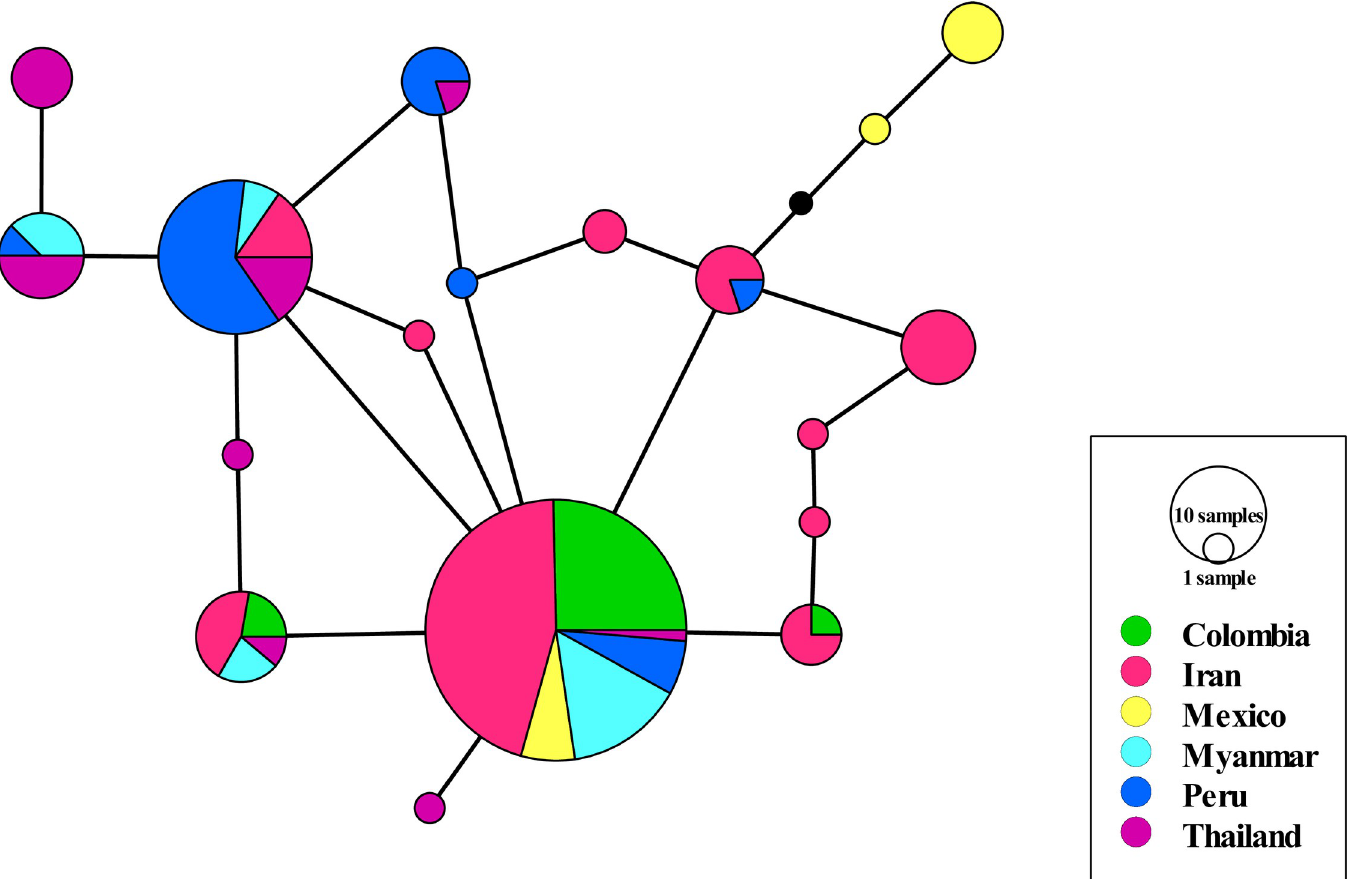
Fig 3. A haplotype network using pvrbp2b DNA sequences of global P . vivax isolates from Iran and other malaria endemic areas (n = 155). The median-joining method was used to construct the haplotype network in PopART software. The detected recombination sites were omitted before haplotype reconstruction by RDP v.4.101 software. The size of the circles specifies the haplotype frequency.